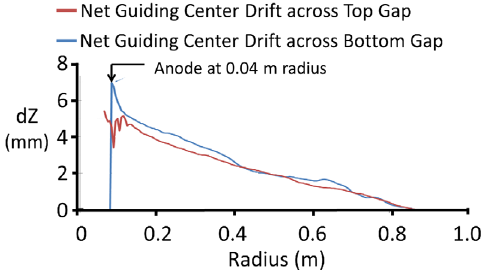
FIG. 28. Guiding center trajectory from the beginning of electron emission to the inner radius of the CSMITL.